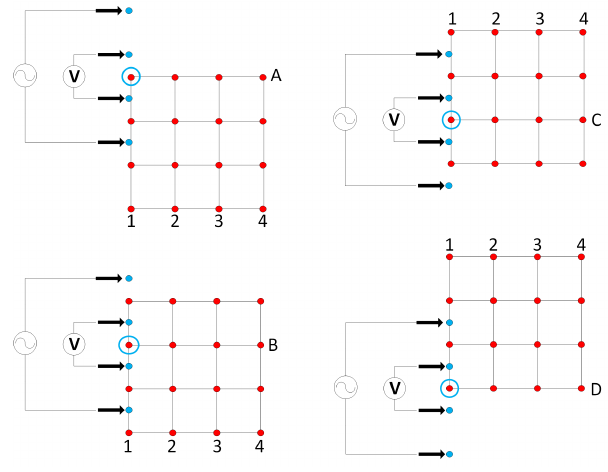
Figure 1. Application of lateral profiling method.